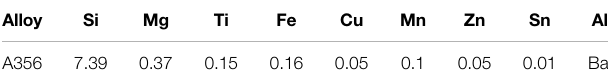
TABLE 1 | Chemical compositions of A356 alloy